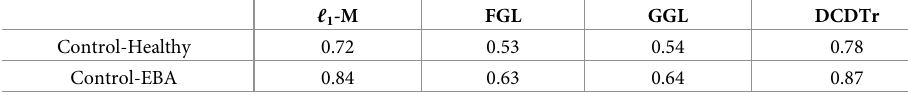
Table 8. The mean reproducibility for various methods and groups.